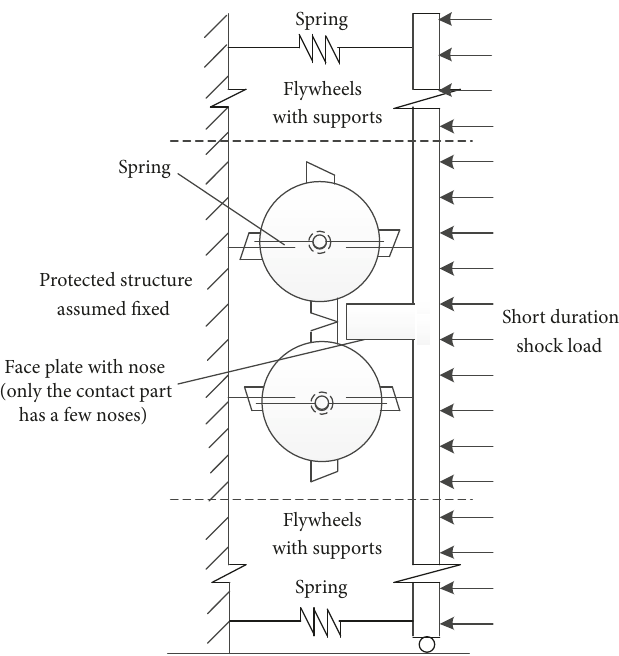
Figure 1: Illustration of the proposed